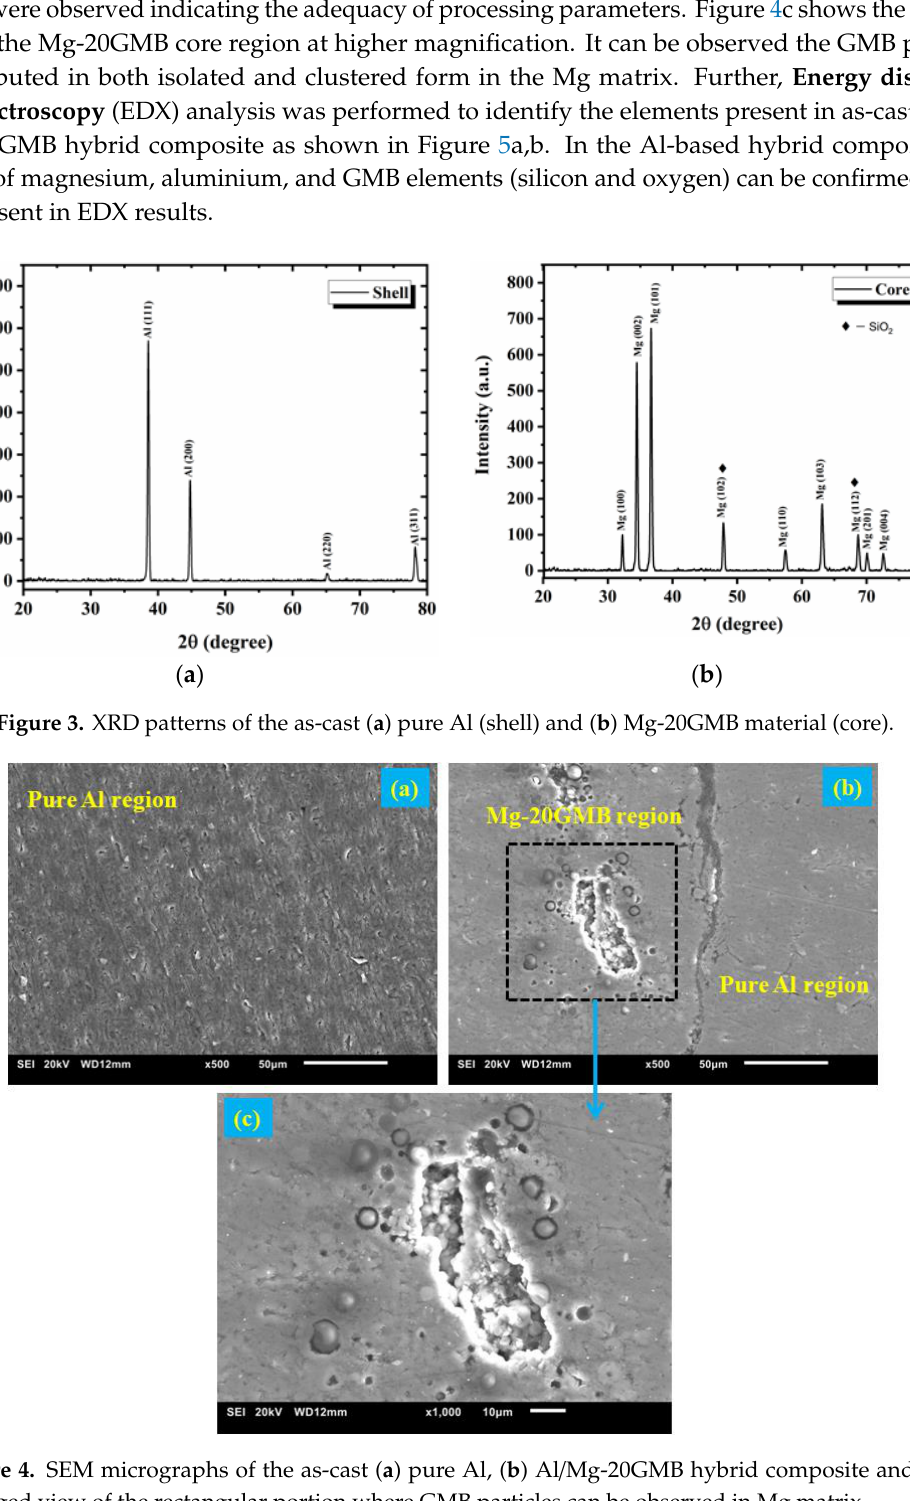
Figure 4. SEM micrographs of the as-cast ( a ) pure Al, ( b ) Al / Mg-20GMB hybrid composite and ( c ) enlarged view of the rectangular portion where GMB particles can be observed in Mg